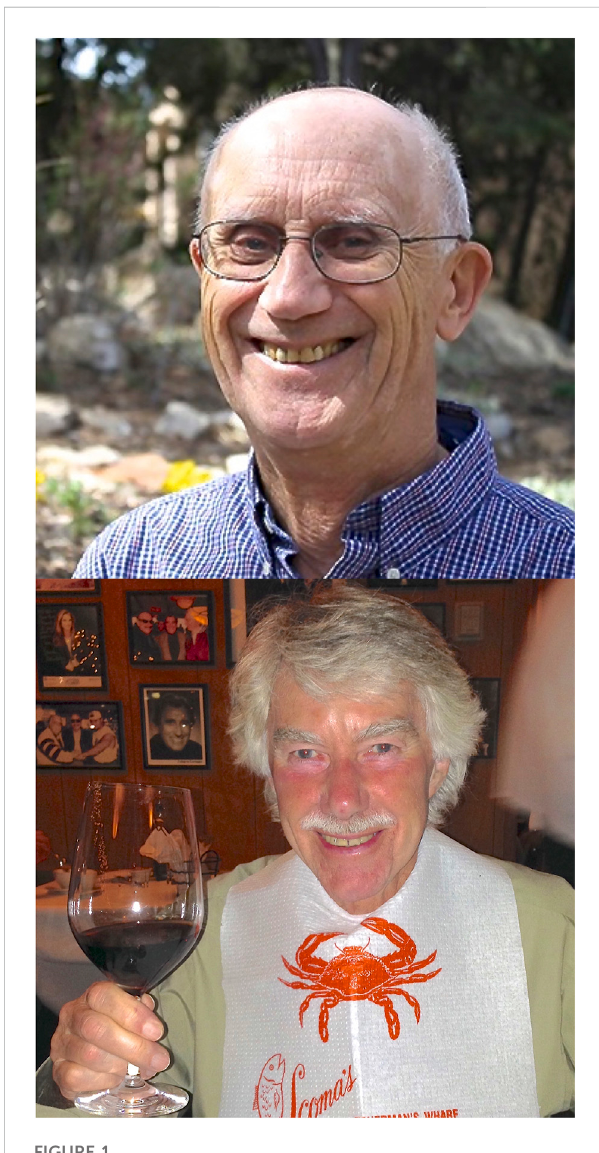
Photographs of Peter Gary (top) and Richard Thorne